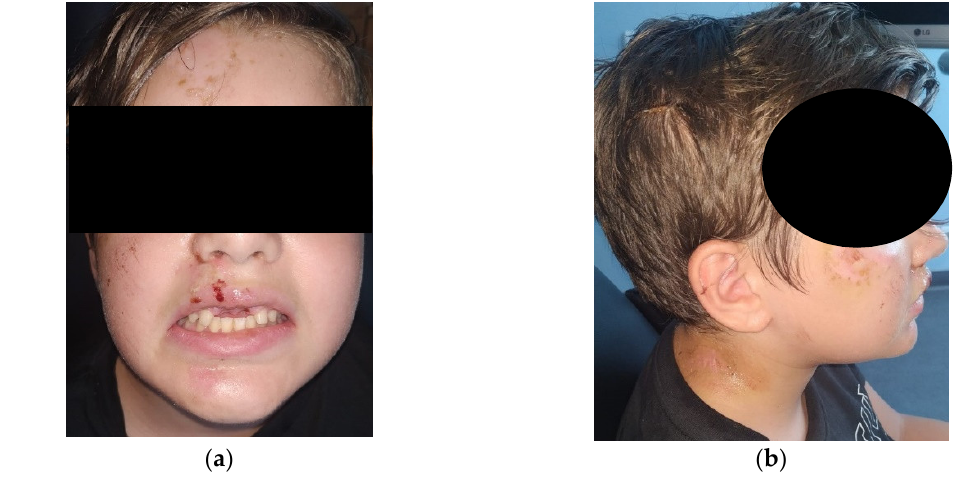
Figure 2. ( a ) Orofacial trauma with upper lip laceration; ( b ) Extension of lesions on the cranio–cervico–mandibular complex.